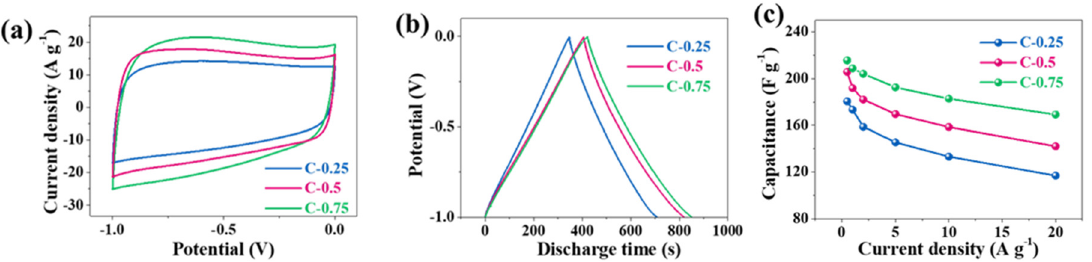
Figure 4. Three-electrode performances in 6 M KOH aqueous electrolytes. ( a ) The cyclic voltammetry (CV), ( b ) galvanostatic charge–discharge (GCD), and ( c ) rate voltammetry (CV), ( b ) galvanostatic charge–discharge (GCD), and ( c ) rate capability